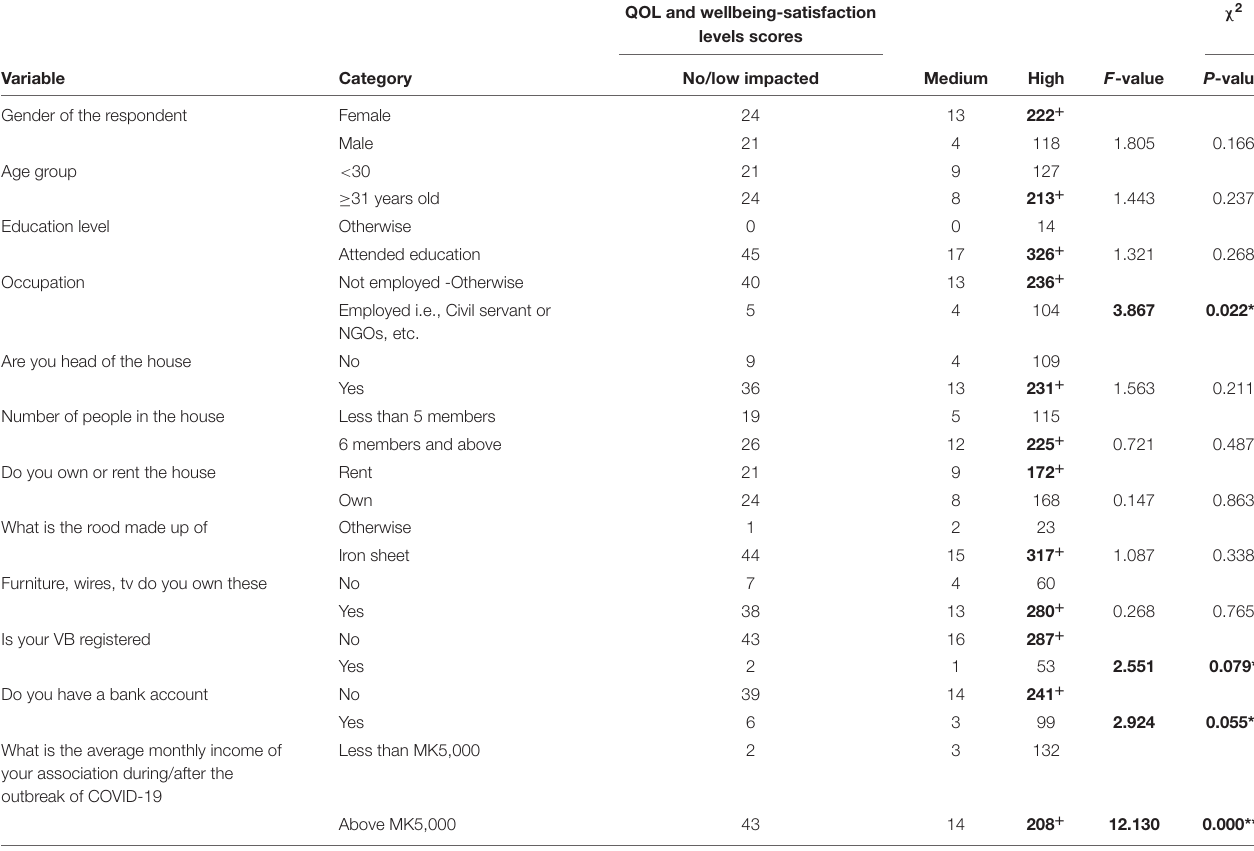
TABLE 4 | Quality of life and wellbeing and demographic and socio-economic characteristics of Village bank